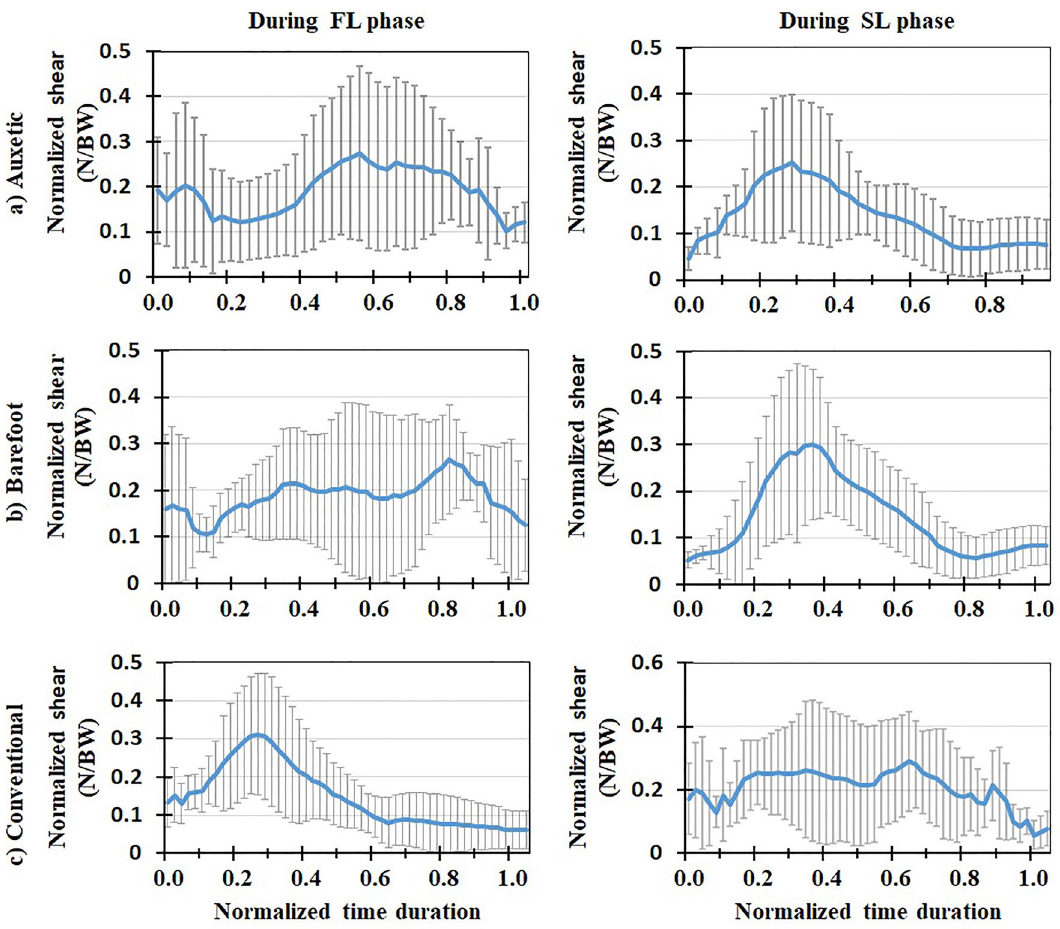
Figure 5. Mean normalized lumbosacral (L5-S1) shear force (N/BW) for all the participants (+ / − one standard deviation) in three footwear conditions: ( a ) auxetic shoe, ( b ) barefoot, and ( c ) conventional shoe. Left and right plots indicate variations during FL and SL phases of DVJ,